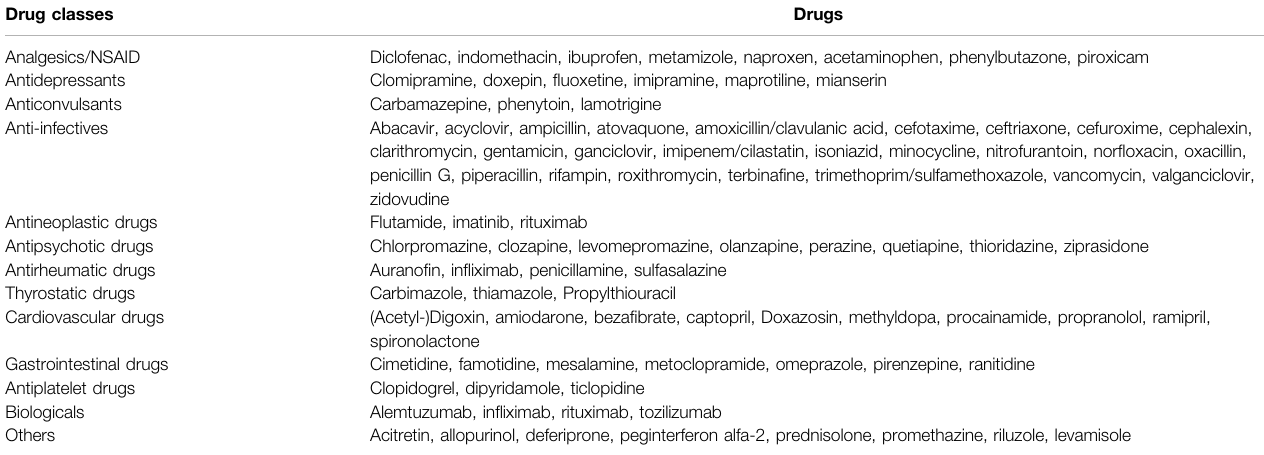
TABLE 1 | Selection ofdrugs withhigh evidence ofcausingidiosyncraticagranulocytosis. Modi fi edaccording to(Andersohn et al., 2007;Andrèsand Mourot-Cottet, 2017). Drug classes Drugs